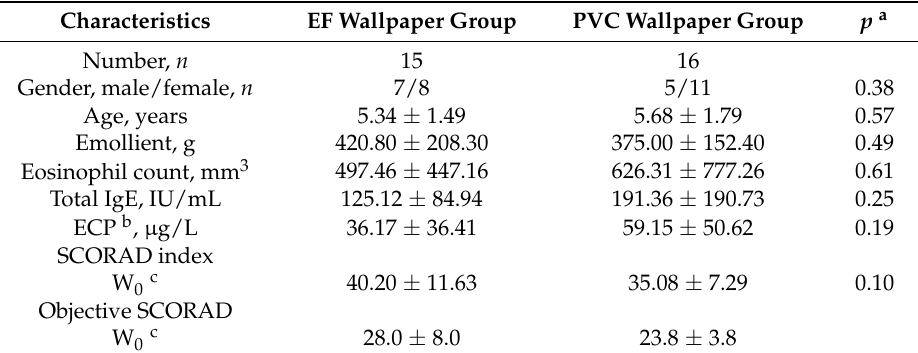
Table 4. Clinical characteristics of the study